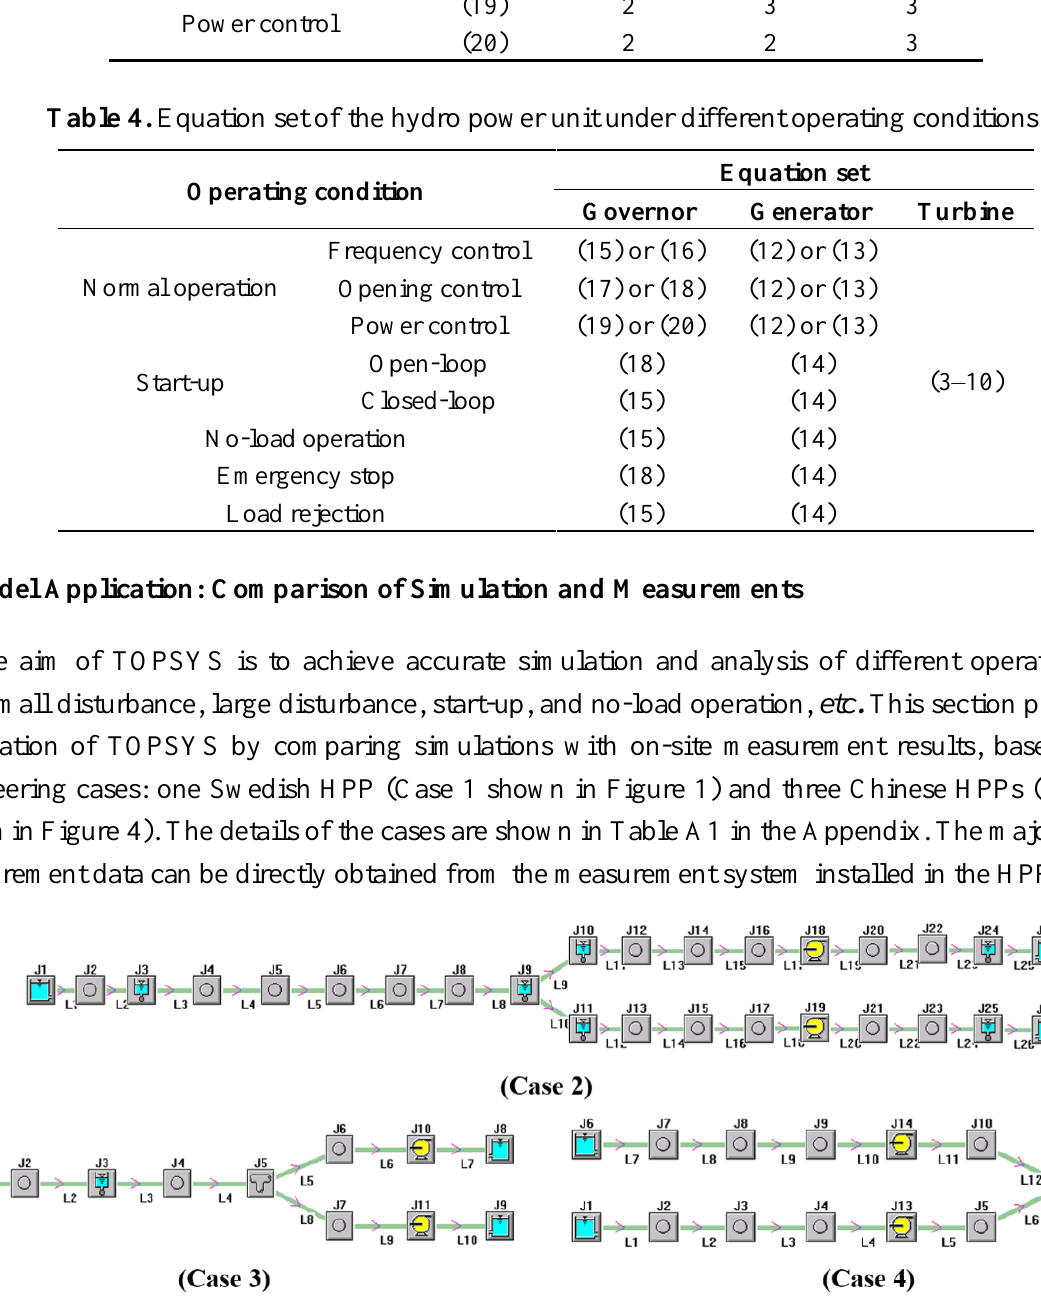
Figure 4. TOPSYS models of three Chinese HPPs with Francis